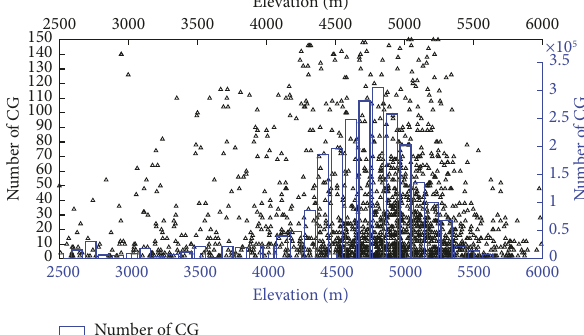
Figure 8: Number of CG lightning flashes per 0.25 ° × 0.25 ° of elevation (triangles) and per 100 m(bars).